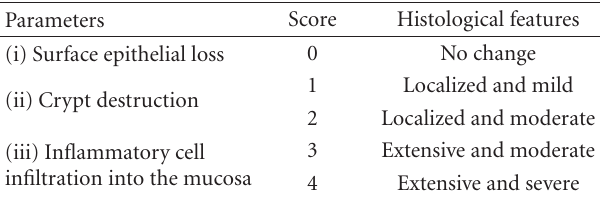
Table 1: Disease activity index (DAI) scoring system. Score Diarrheal stool score Bloody stool score Normal colored stool Brown stool Reddish stool Watery stool Bloody stool The sum of the scores of two parameters was defined as the DAI score. Table 2: Histological damage scoring system. Parameters Score Histological